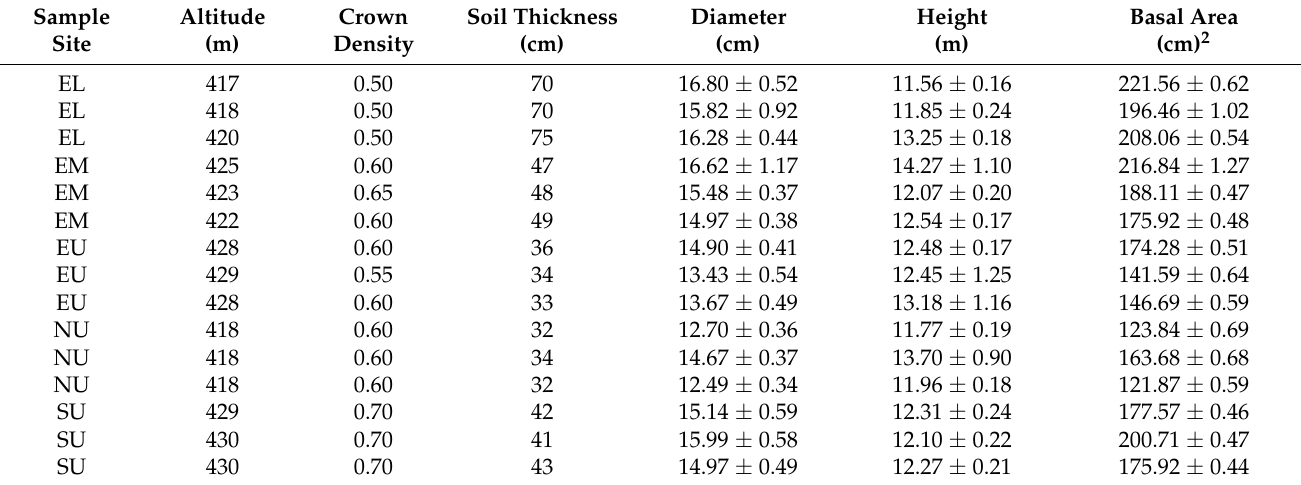
Table 1. Site characteristics of different topography of L. olgensis plantations.